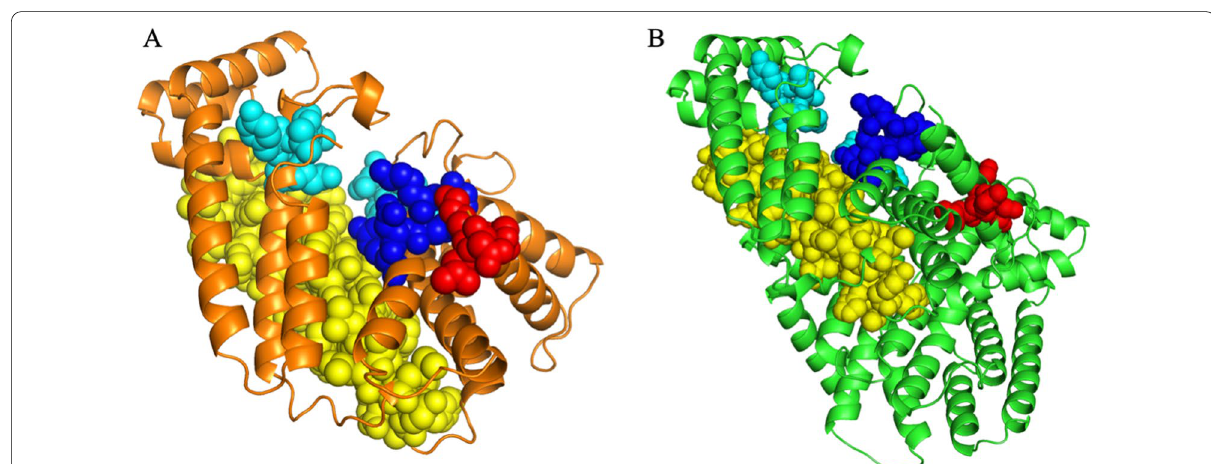
Fig. 3 Spatial structure models and domain analysis of FPPS gene. A 7bux.1. A model, B DnFPPS1 model; sequence identity 73.56%. Conserved regions, motif I, motif II, motif III and motif IV, are separately depicted as spheres in red, blue, cyan and